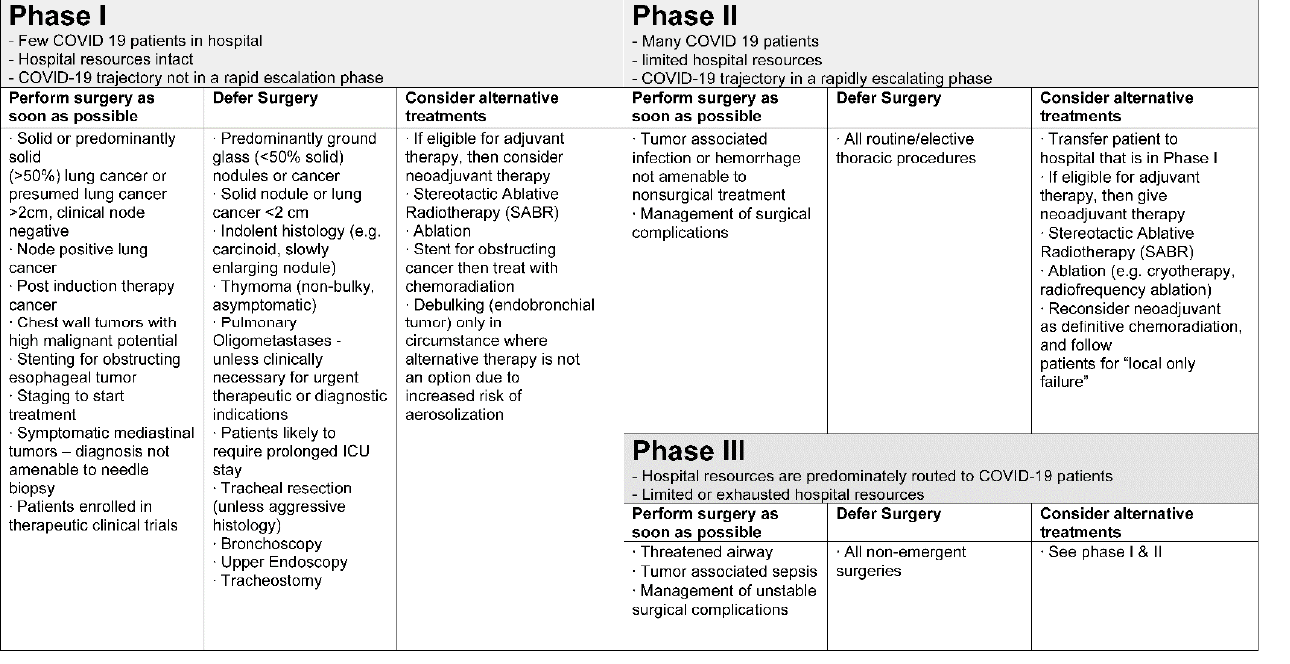
Figure 2. Triage compass based on the recommendations of the Thoracic Surgery Outcomes Research Network [51]. 21. surgery (SRC A).